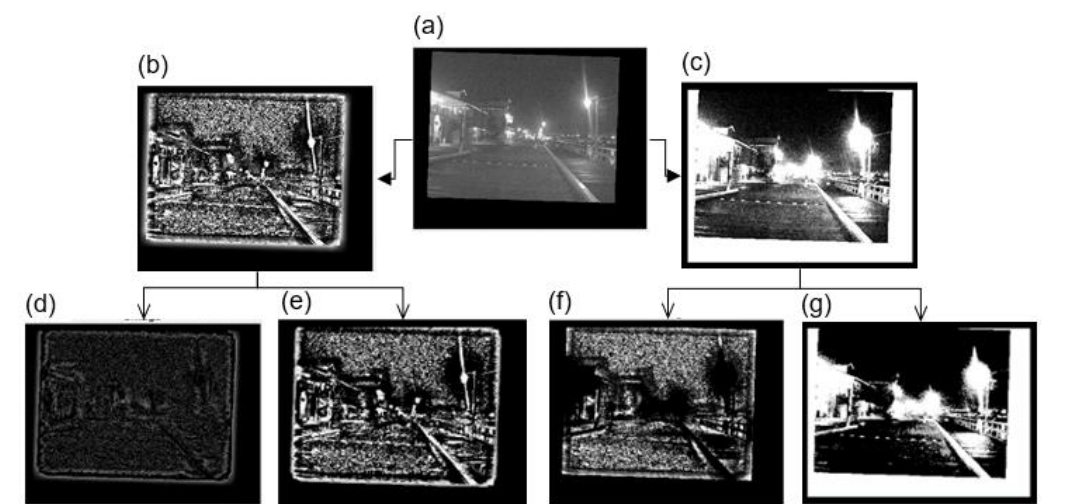
Figure 6. Extracting night image FLIR_06001 ( a ) to the local anomaly ( b ) and global anomaly ( c ). Both local and global anomaly images can be segmented into the background, ( d , f ), and foreground, ( e , g ).